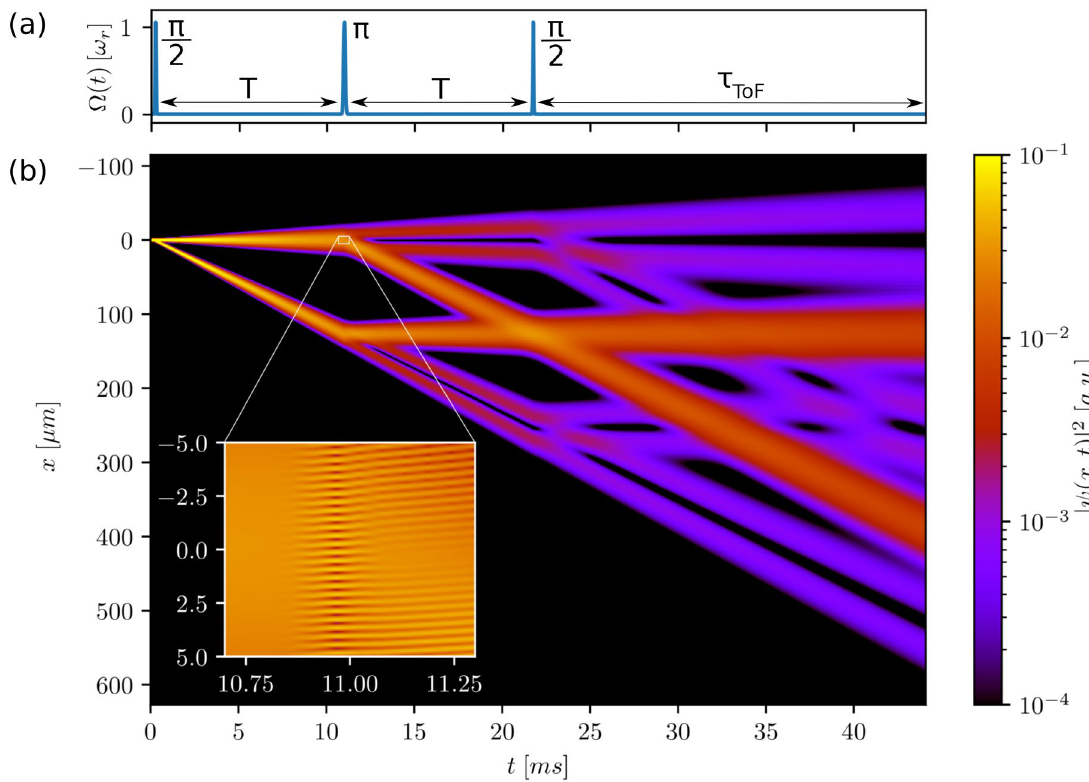
Figure 2. ( a ) Rabi frequency �( t ) over time of a 2 (cid:31) k -Bragg Mach–Zehnder interferometer according to 2 . The initial momentum ψ( x , t ) Eq. (2). ( b ) Corresponding space-time diagram of the probability density | | 0.1 (cid:31) k and the splitter and mirror Gaussian pulses have peak Rabi frequencies of width is chosen to be σ p = 50 µ s, respectively. The separation time between the 1.0573 ω 25 µ s and τ (cid:31) r with pulse lengths of τ bs = m = = 20 ms. Due to the velocity 10 ms with a final time of flight after the exit beam splitter of τ pulses is T ToF = = selectivity of the Bragg pulses, several trajectories can be observed after each pulse. Inset: Additional insight into the dynamics of the mirror pulse of the upper arm. The peak amplitude of the Gaussian pulse is reached 11 ms. The interference fringes of the density plot indicate the overlap between the atoms in momentum at t = 2 (cid:31) k and the atoms lost due to velocity selectivity remaining at p 0 (cid:31) k class p = =